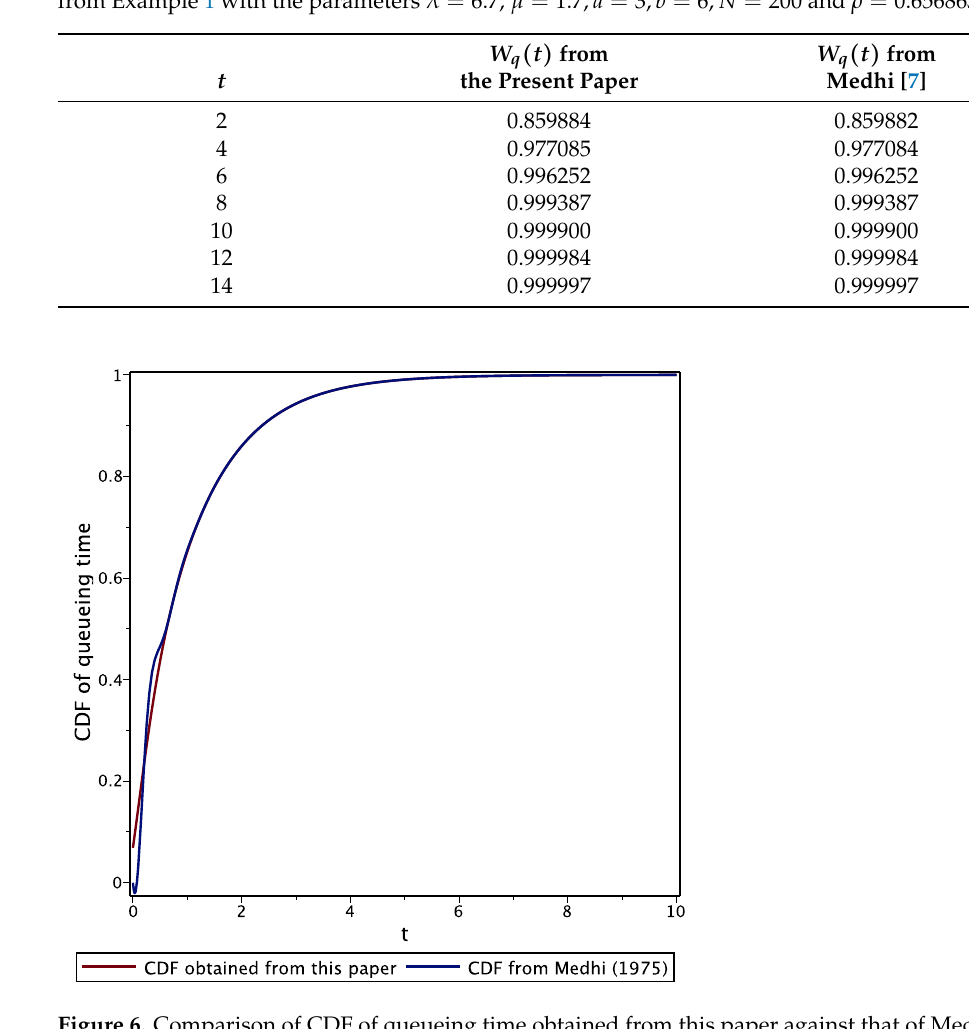
Table 7. Comparison between numerical results for CDF of queueing time of a random customer from Example 1 with the parameters λ = 6.7, µ = 1.7, a = 3, b = 6, N = 200 and ρ = 0.656863.